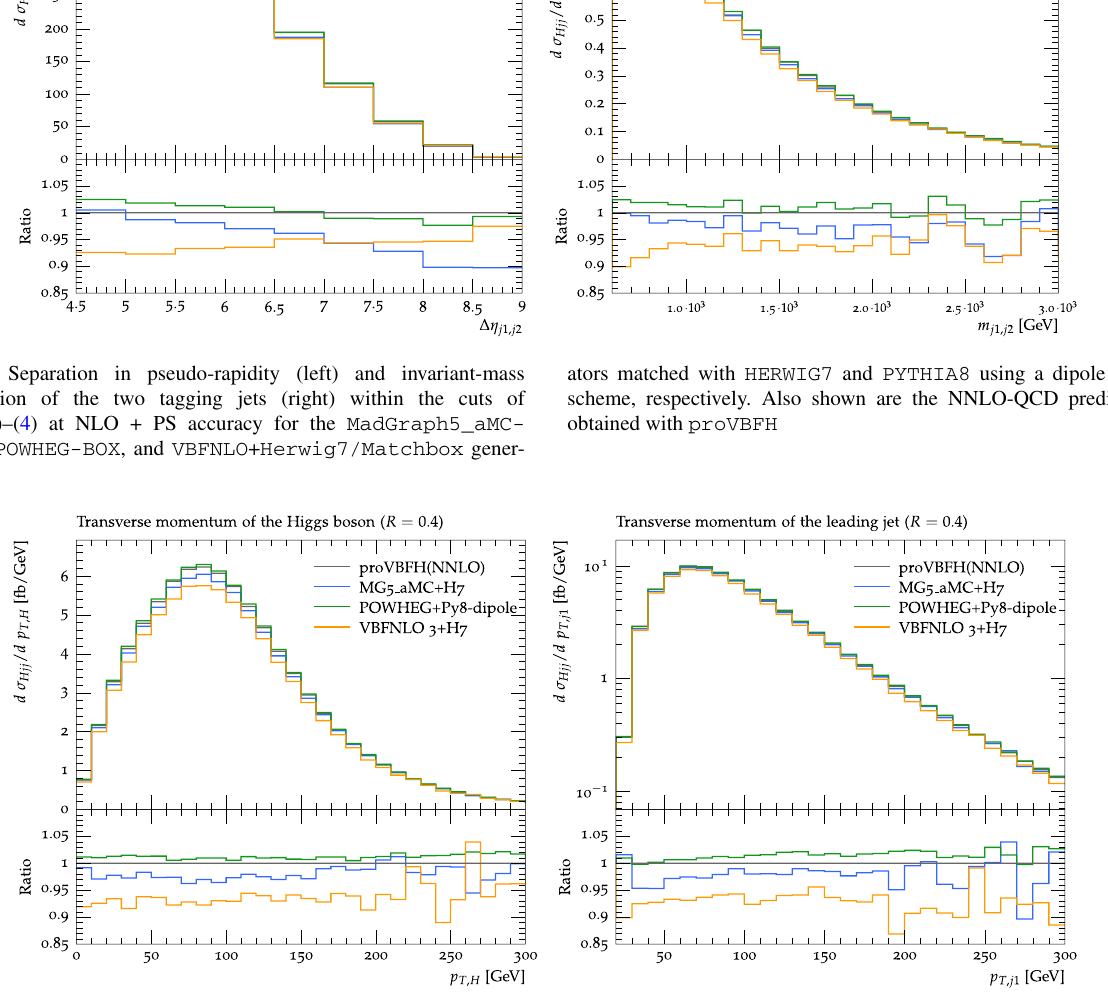
ators matched with HERWIG7 and PYTHIA8 using a dipole recoil scheme, respectively. Also shown are the NNLO-QCD predictions obtained with